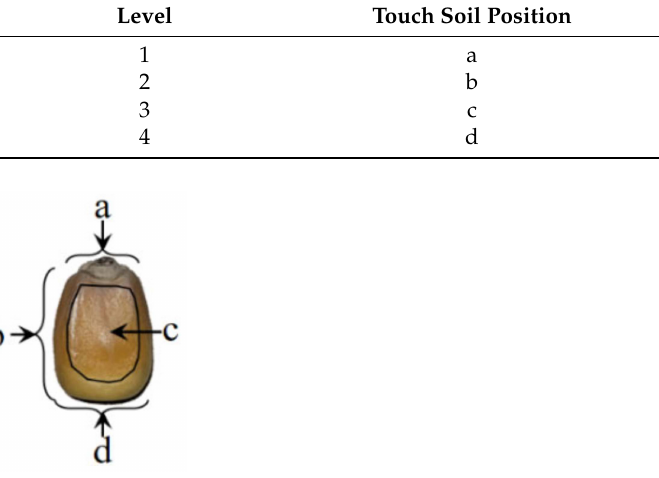
Figure 8. The position of seed touching the